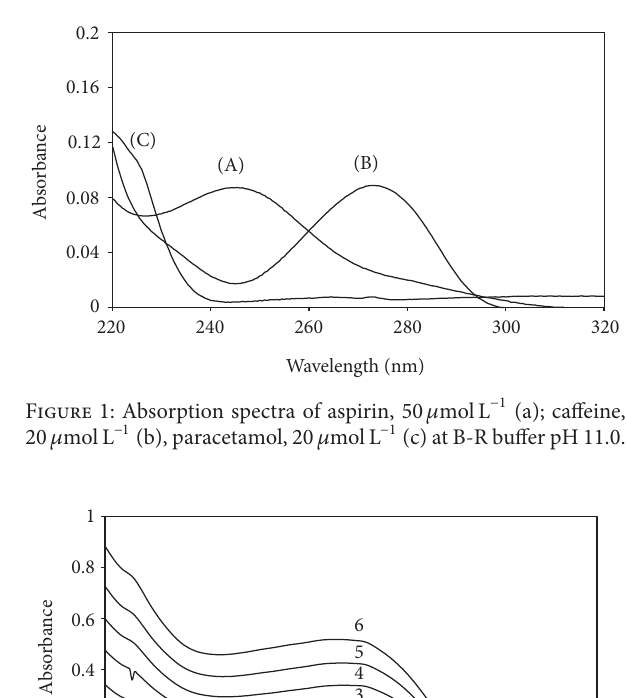
for spectra 1–6. e molL −1 𝜇𝜇